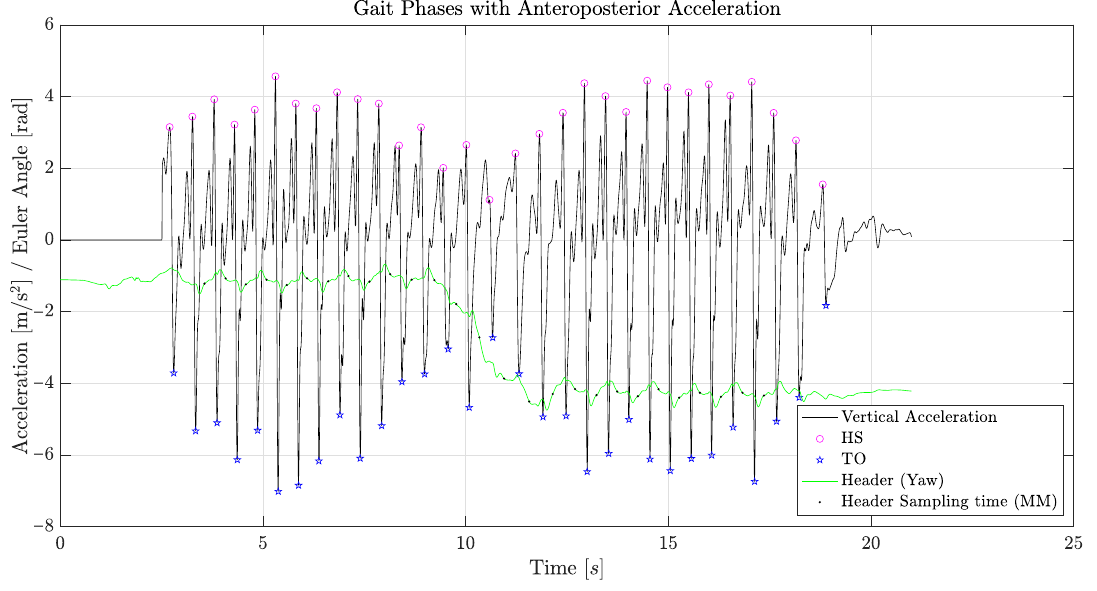
Figure 6. Gait phases obtained from the anteroposterior accelerometer of the BTS